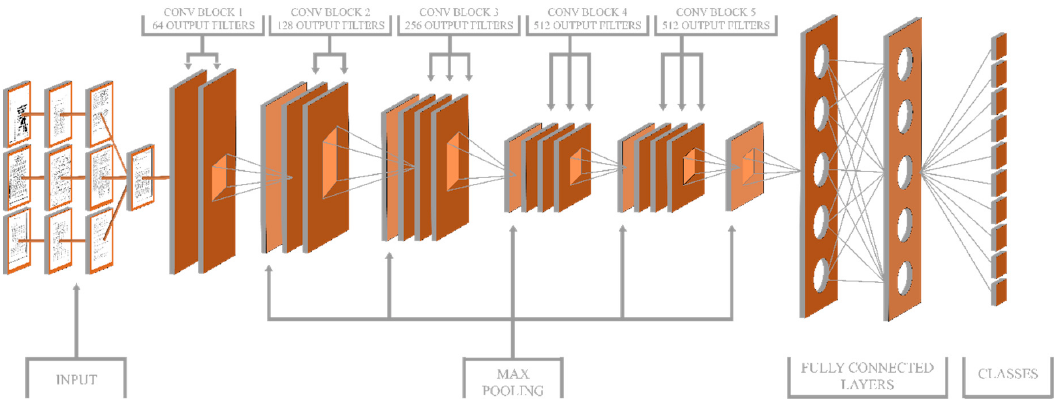
Figure 4. Structure of VGG19 Model.